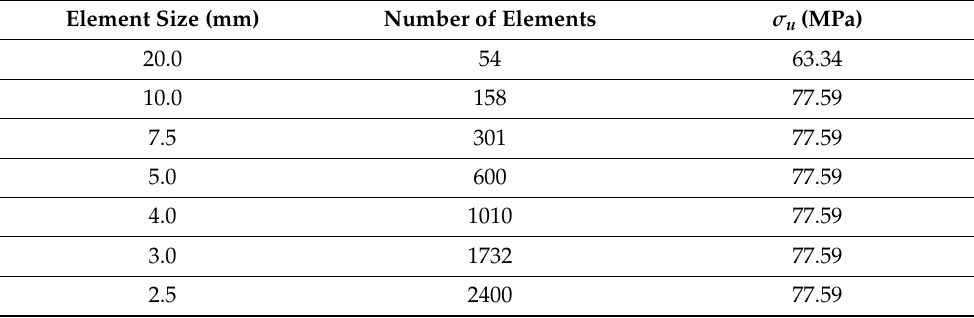
Table 10. Mesh convergence test for the validation of the computational model by Narayanan and Chow [29].